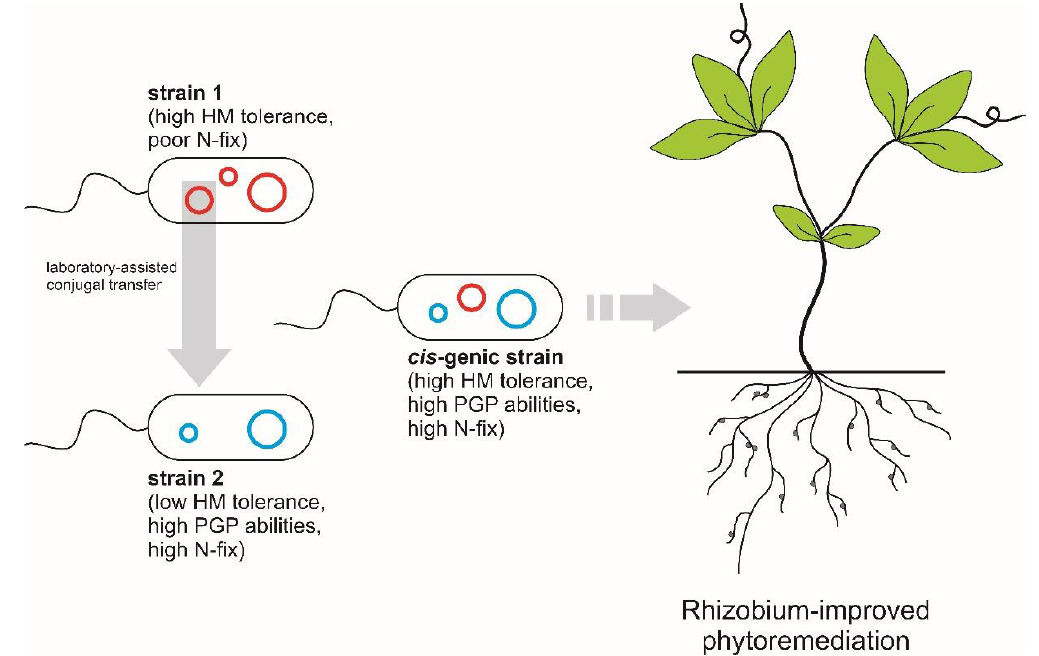
Figure 2. A synthetic biology-based proposal to increase rhizobial-mediated heavy-metal tolerance. Surveys of rhizobial phenotypic and genetic diversity in heavy-metal (HM) rich areas facilitates the discovery of strains (strain 1) with high levels of heavy-metal resistance. However, such strains may not be competitive or good nitrogen-fixers in the crops to be used for phytoremediation. The simultaneous transfer of a large collection of genomic determinants that contribute to HM tolerance, good PGP, and/or nitrogen fixation (N-fix) abilities between two or more strains (strain 2) could create hybrid strains ( cis- genic strain) with improved features for application in the field for phytoremediation.